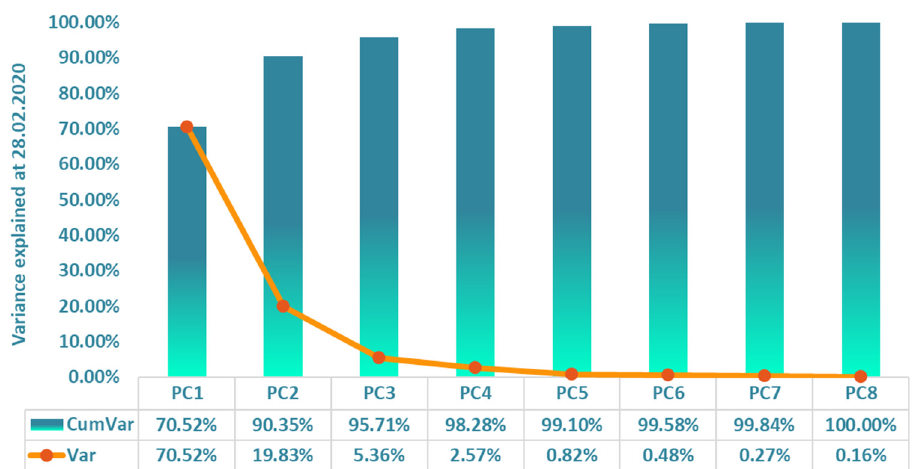
Figure 5. Yield curve variability explained by principal components on 28 February 2020. Source: Bloomberg, own computation of PCs with the use of a VBA add-in developed by Leonardo Volpi.